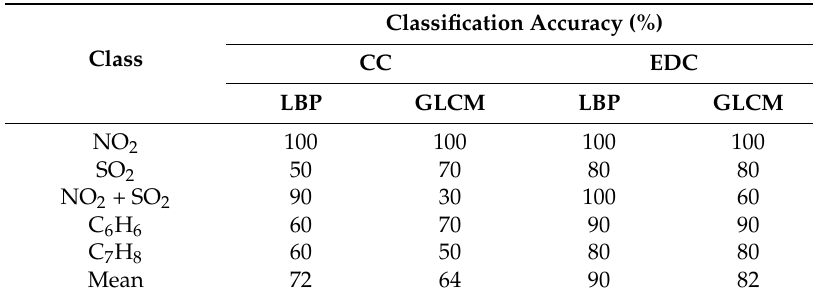
Table 4. Classification accuracy of